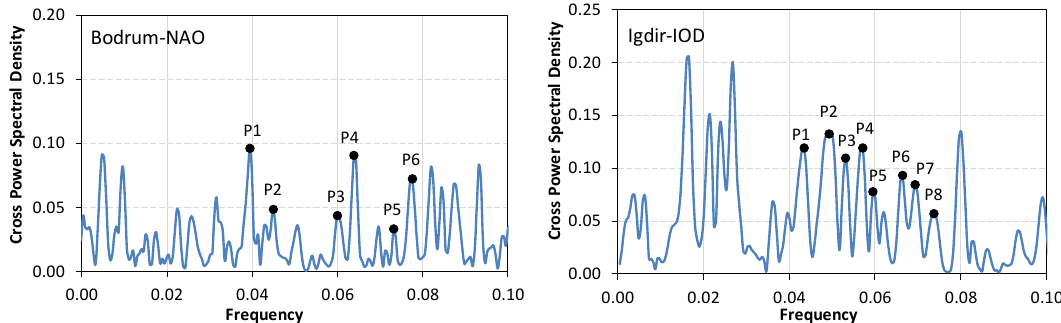
Figure 12. Cross-spectral analysis results of Bodrum-NAO and Igdir-IOD with removed harmonics. The frequencies, periods (months), CPSD values, and phase shift (months) of the peaks for the removed harmonics were given in Table 2.